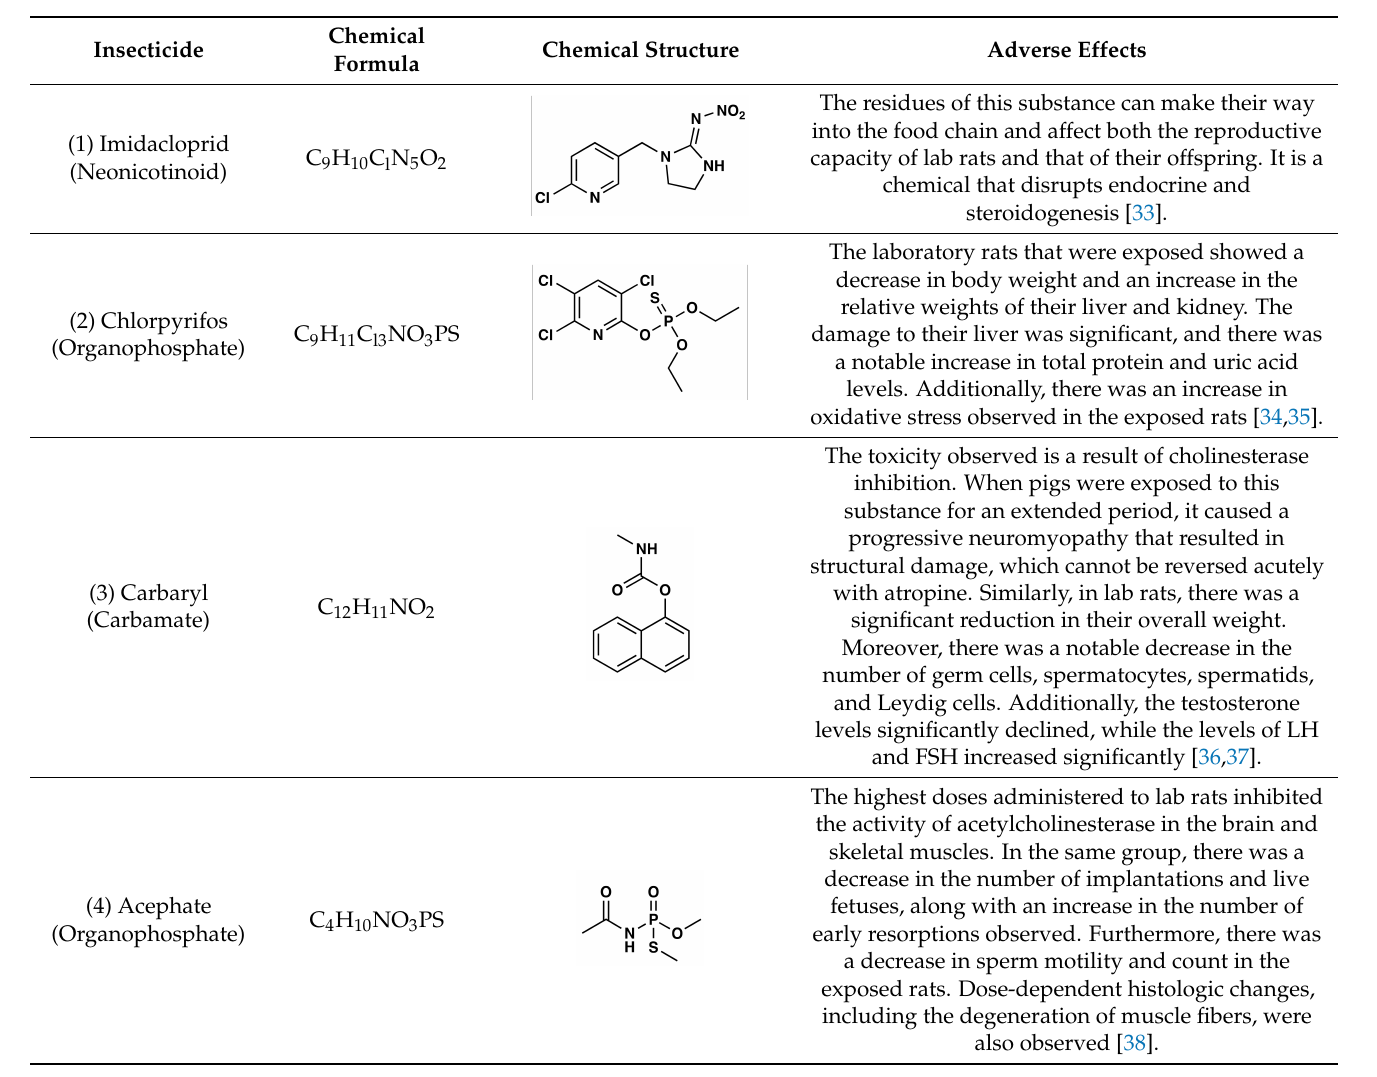
Table 1. Structural and chemical composition, as well as corresponding adverse effects, of the ten currently most used insecticides in